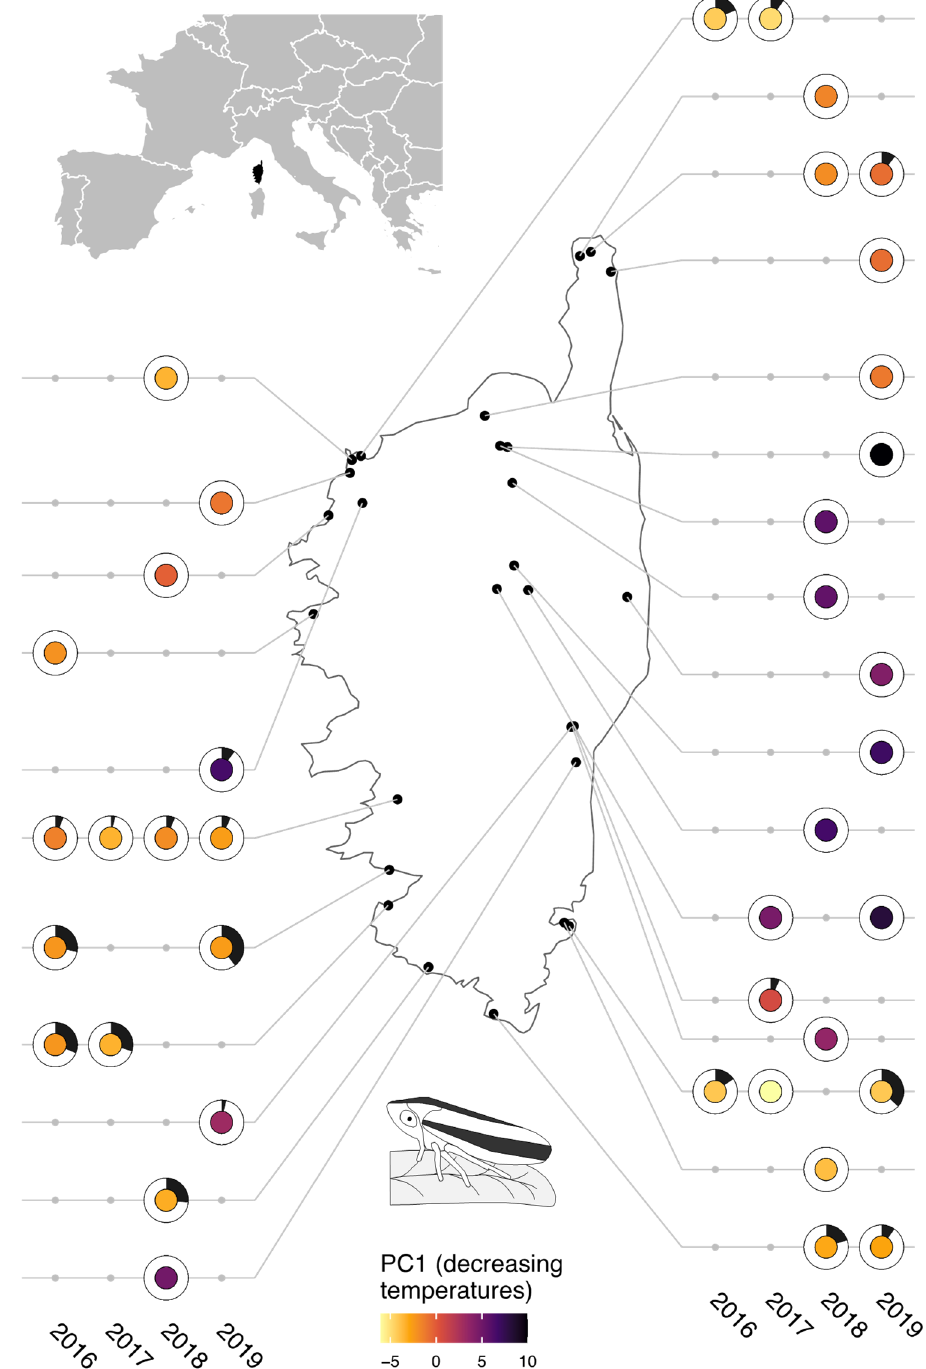
Figure 1. Prevalence of X. fastidiosa in populations of insect vectors. The black portion of each donut represents the proportion of specimens from which Xf was sequenced. The color of the pies shows the score of the sampling sites on PC1 of the PCA performed on climate variables (the warmest colors correspond to the highest temperatures).